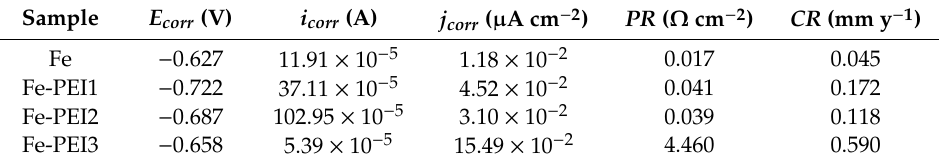
Table 3. Electrochemical parameters of the Fe and Fe-PEI samples obtained from the Tafel analysis